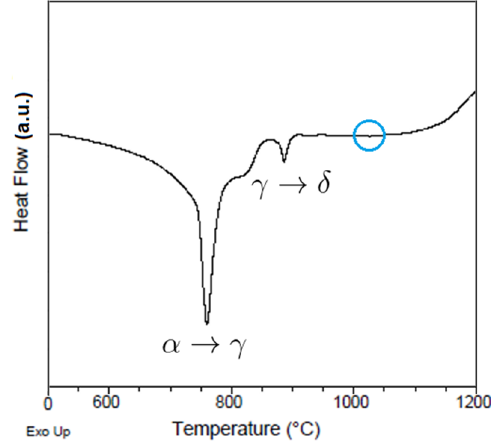
Figure 14. Thermal analysis of 8628 steel at a continuous heating rate of 20 K/min.